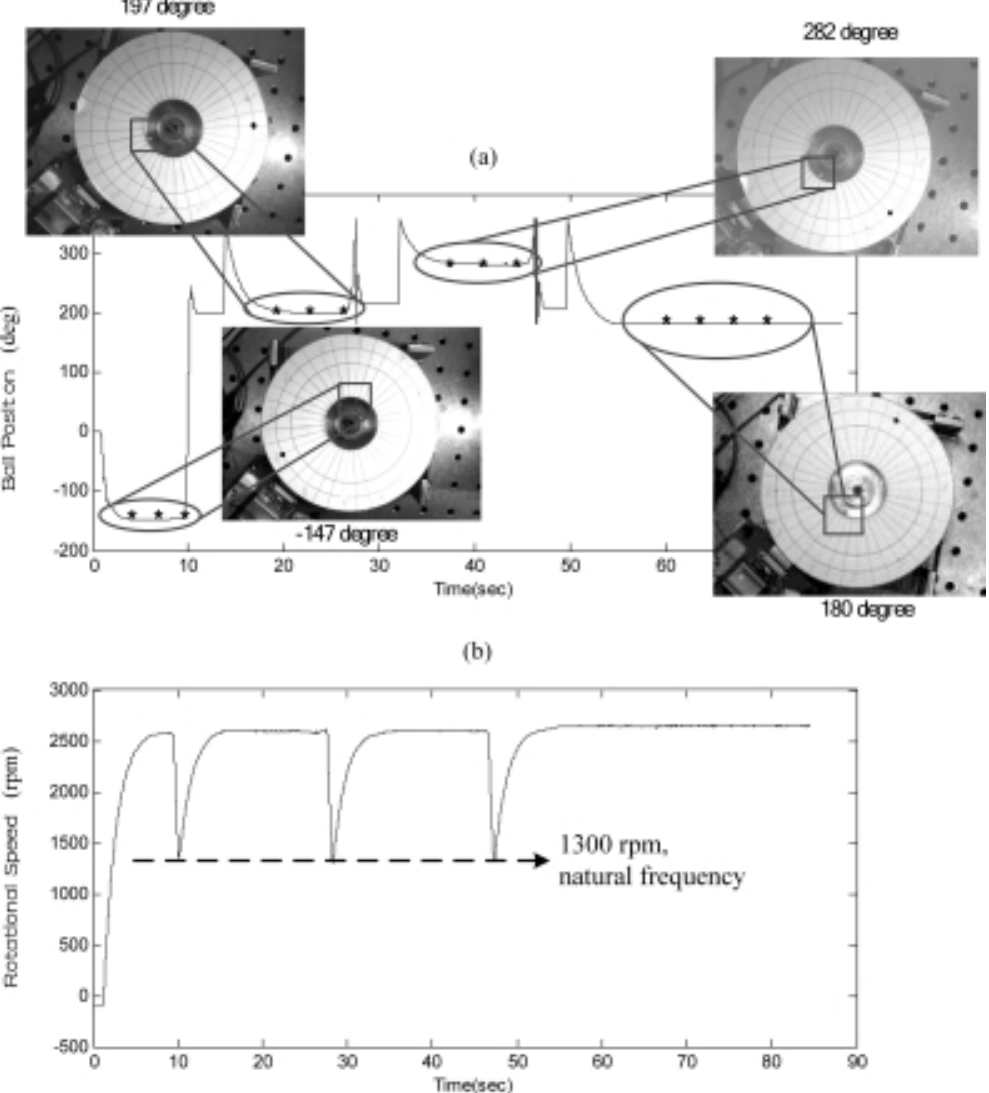
Fig. 16. Experimental results by the ball re-positioning scheme with operation speed 2600 rpm, experiencing three trials of speed drops. (a) Ball position versus time and the corresponding pictures, where the solid line, “–”, represents the observed results and the stars, “*”, denotes the actual ball positions. (b) The rotating speed of spindle motor versus